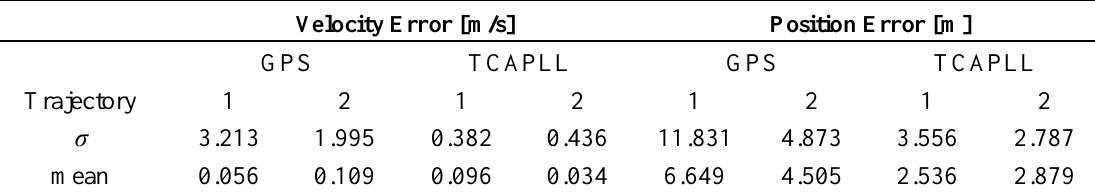
Table 6. Standard deviation and mean of the GPS and TCAPLL velocity and position